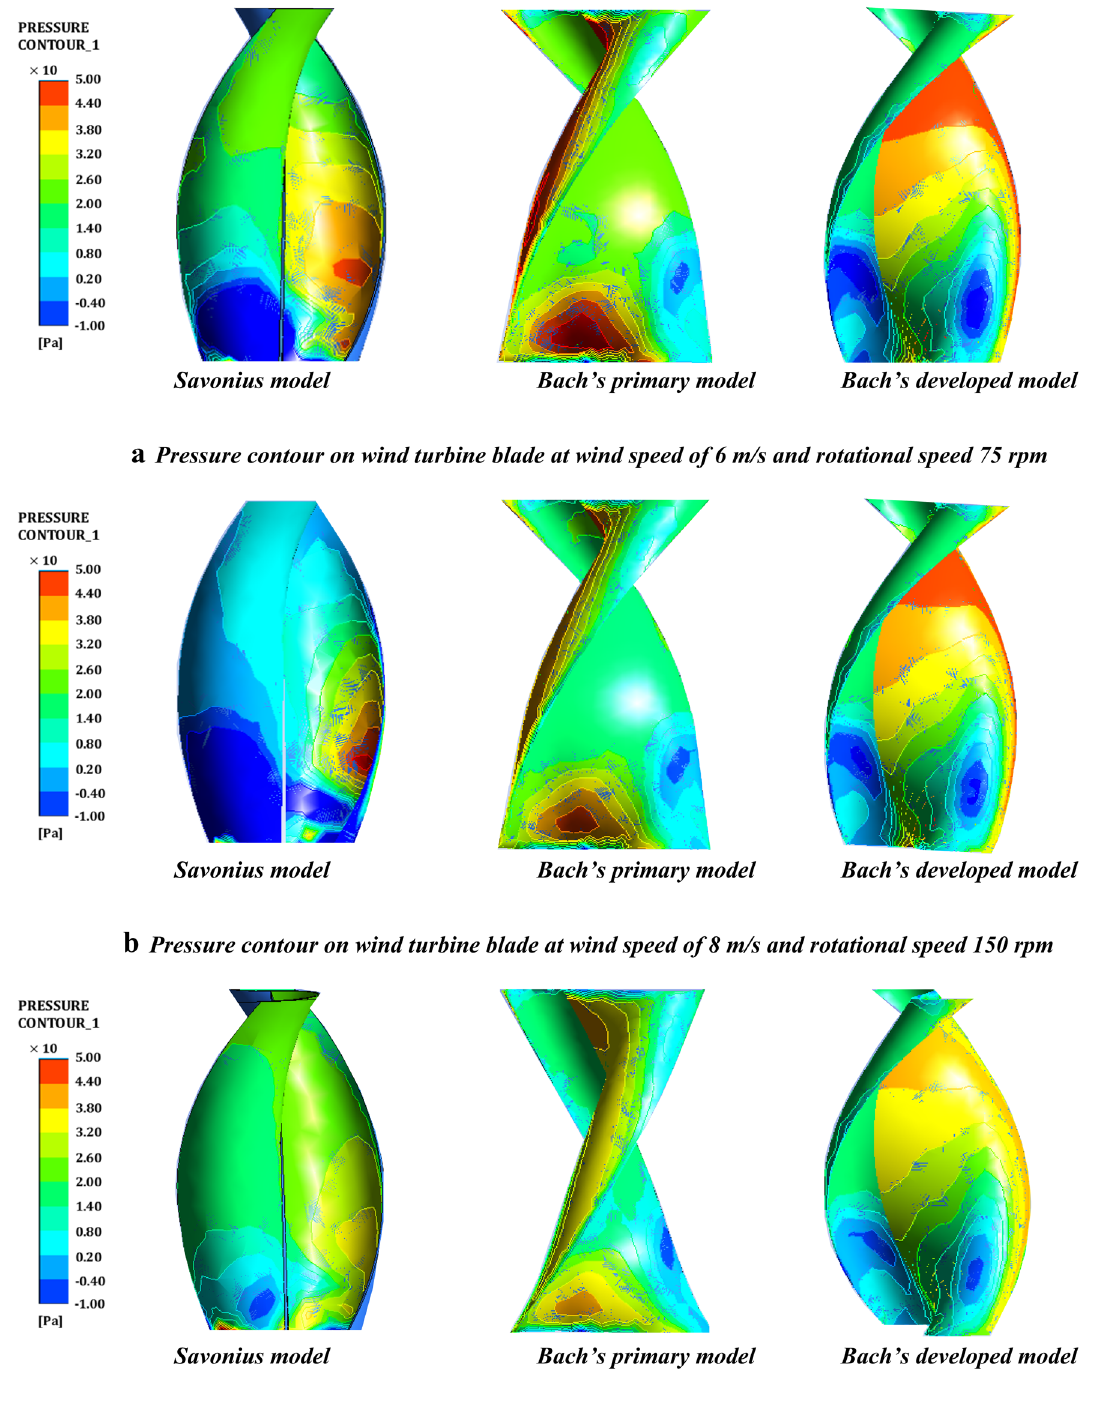
c Pressure contour on wind turbine blade at wind speed of 10 m/s and rotational speed 250